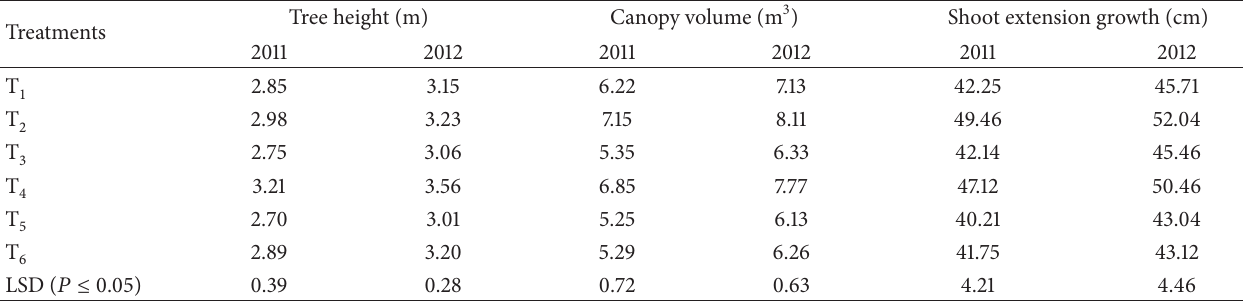
Table 2: Effect of N&K fertigation on primary, secondary, and tertiary branches in almond.